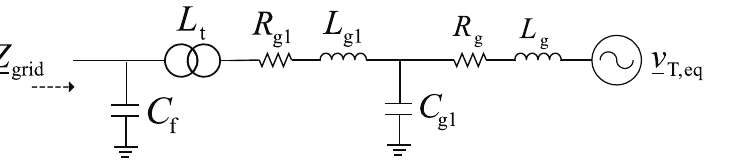
Figure 6. Schematics of the connecting grid showing the input-impedance, Z grid together with its comprising passive components for investigating resonance instability.